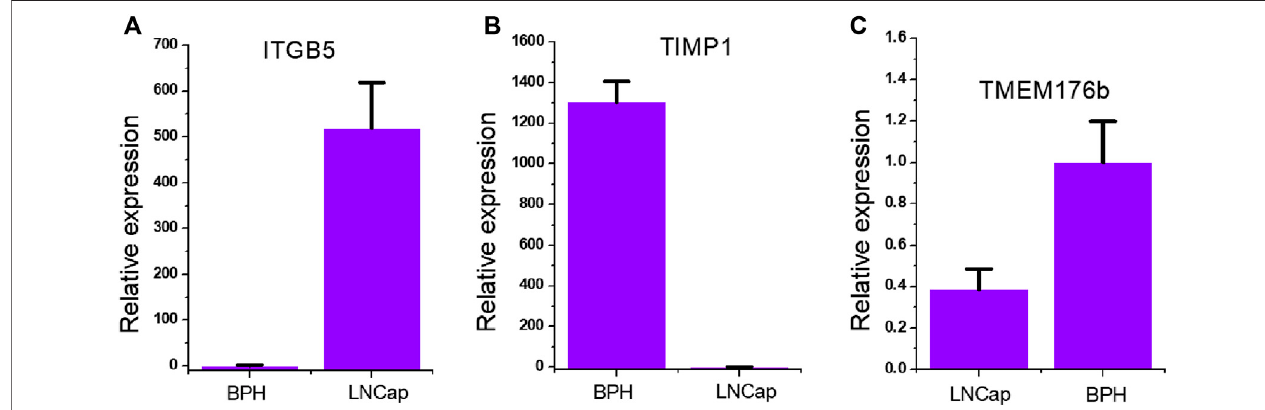
FIGURE 1 | Expression of ITGB5, TIMP1, TMEM176B in prostate cancer cells. (A) qRT-PCR analysis of ITGB5 expression in LNCap and BPH cell lines. (B) qRT- PCR analysis of TIMP1expression in LNCap and BPH cell lines. (C) qRT-PCR analysis of TMEM176Bexpression in LNCap and BPH cell lines.